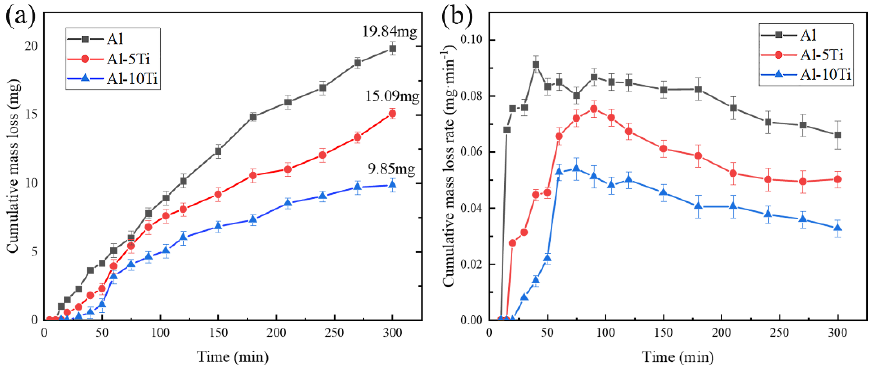
Figure 3. The cumulative mass loss curves ( a ) and the cumulative mass loss rate curves ( b ) in 3.5 wt.% NaCl solution.